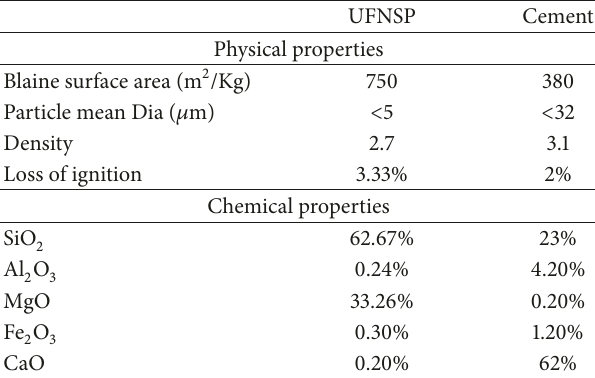
Table 1: Properties of UFNSP.